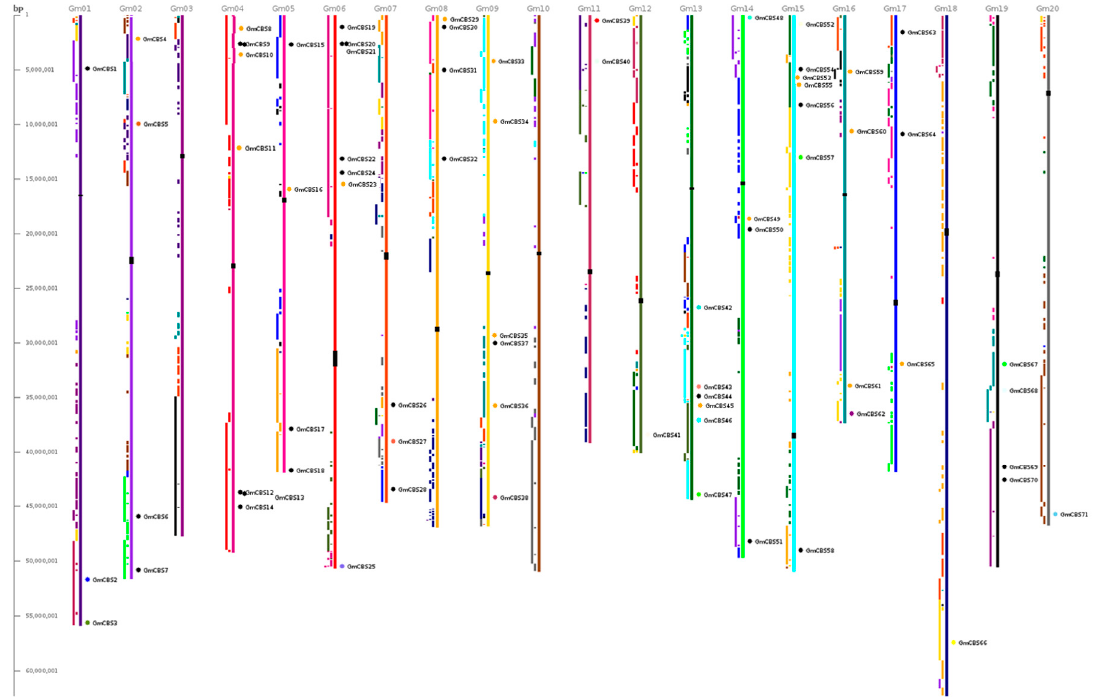
Figure 3. Chromosomal location and region duplication of GmCBS genes. The schematic diagram of genome-wide chromosome organization and segmental duplication was made from the CViT genome search and synteny viewer at the Legume Information System. Colored blocks to the left of each chromosome show duplications with chromosomes of the same color.